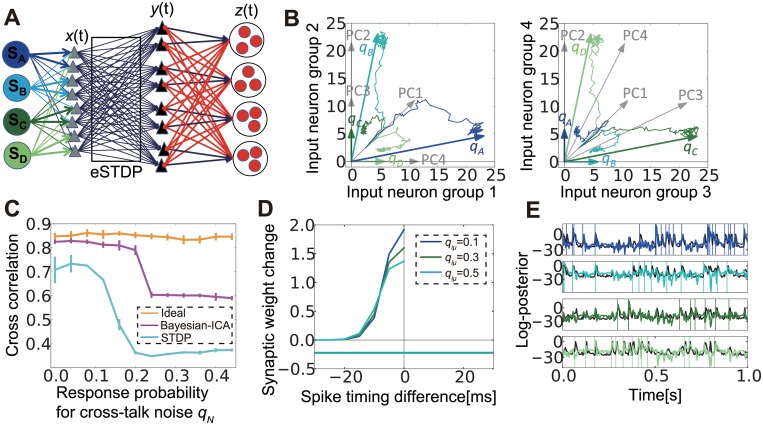
With lateral inhibition, spike-timing-dependent plasticity (STDP) mimics Bayesian independent component analysis (ICA).(A) Schematic figure of the model with four sources. (B) Synaptic weight development in input neuron space. Arrows q
A to q
D are response probability vectors of the four sources, and PC1 to PC4 are normalized principal components of the correlation matrix C. Lines represent traces of average synaptic weight from each input group to the output groups that learned corresponding sources during the learning process. (C) Comparison of performance among the ideal observer, Bayesian ICA learning, and STDP learning. (D) LTP/LTD time window of Bayesian ICA learning. (E) Behaviors of log-membrane potential (color lines) in the STDP model, and estimated log-posterior (black lines) in the Bayesian ICA algorithm for the same stimuli. Vertical lines represent timings of external events. Log-membrane potentials are normalized to align the mean and the variance to the corresponding log-posteriors.